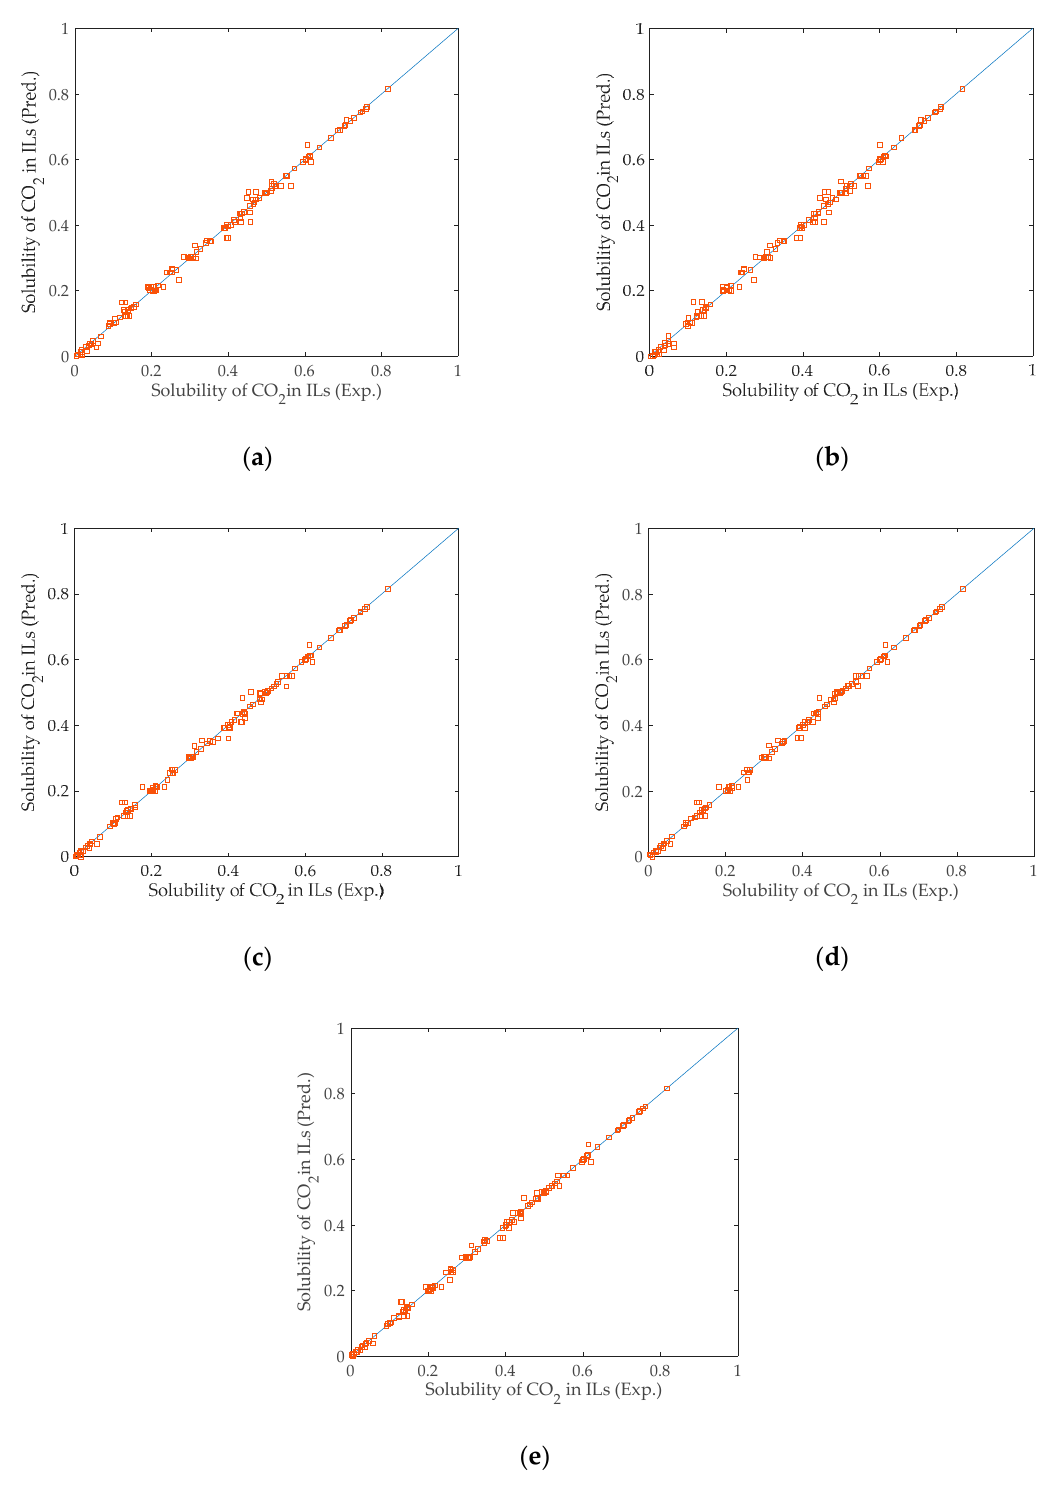
Figure 3. Prediction performances of five models: ( a ) Optimal BPNN; ( b ) Optimal ELM; ( c ) Optimal RBFNN; ( d ) Fully integrated model; and ( e ) Selective ensemble model.